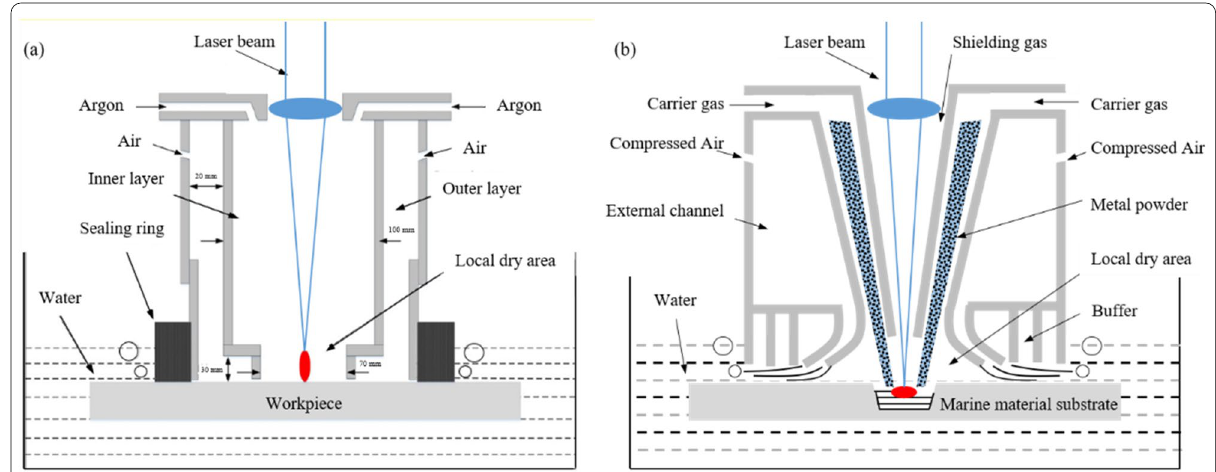
Figure 2 Schematic of ( a ) a double-layer gas curtain nozzle developed by Harbin Institute of Technology in China [20] and ( b ) a gas curtain nozzle with an annular buffer developed by the author’s group in Southeast University in China